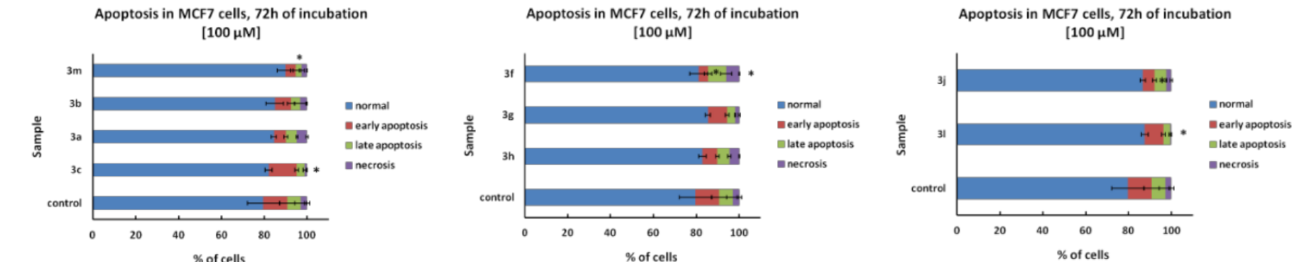
Figure 8. Apoptosis in MCF-7 cells after a 72 h incubation with compounds with a concentration of 100 µ M. The results were presented as mean value ± SD. The statistical analysis was based on a t-test, and a p -value less than 0.05 was considered statistically significant in comparison to the untreated controls (indicated with a star).